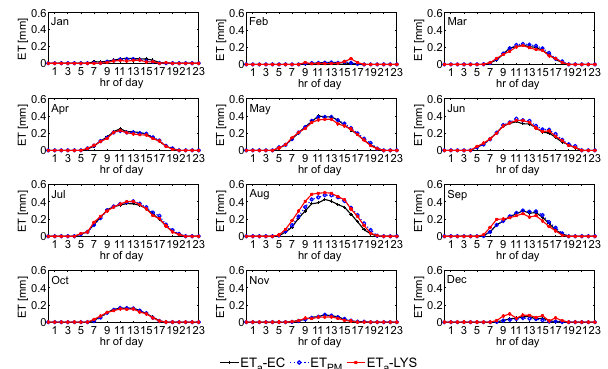
Figure 12. Mean daily cycle of ET a -LYS, ET a -EC and ET PM for